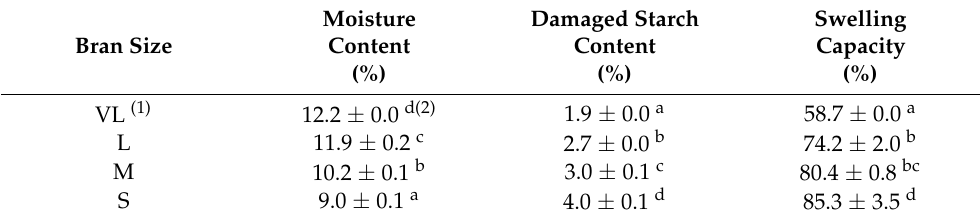
Table 2. Moisture and damaged starch contents and swelling capacities of purple-colored wheat bran with different sizes.